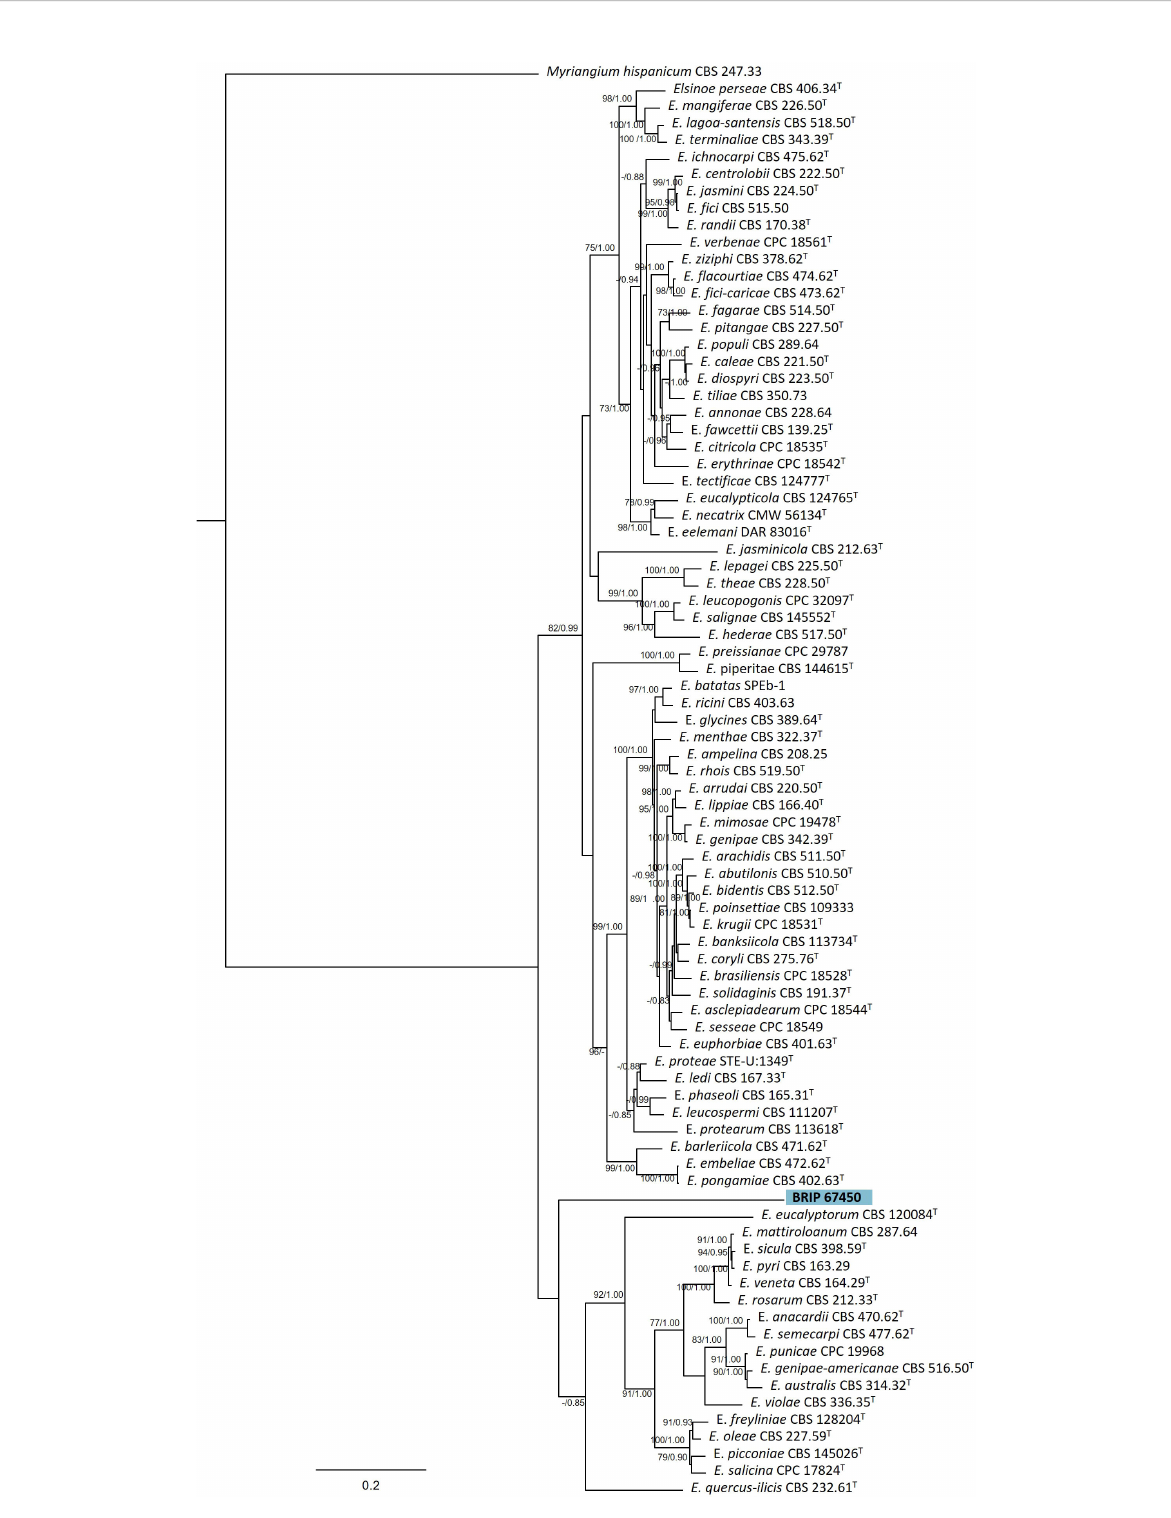
FIGURE 9 Phylogenetic tree inferred from a RAxML analysis based on a concatenated alignment of ITS, LSU, rpb2 and tef1 - a sequences of related genera from Elsinoaceae (Myriangiales). RAxML bootstrap (bs) values greater than 70% and Bayesian posterior probabilities (pp) greater than 0.8 are given at the nodes (bs/pp). In bold font is the isolate from this study, and ex-type strains are indicated with T